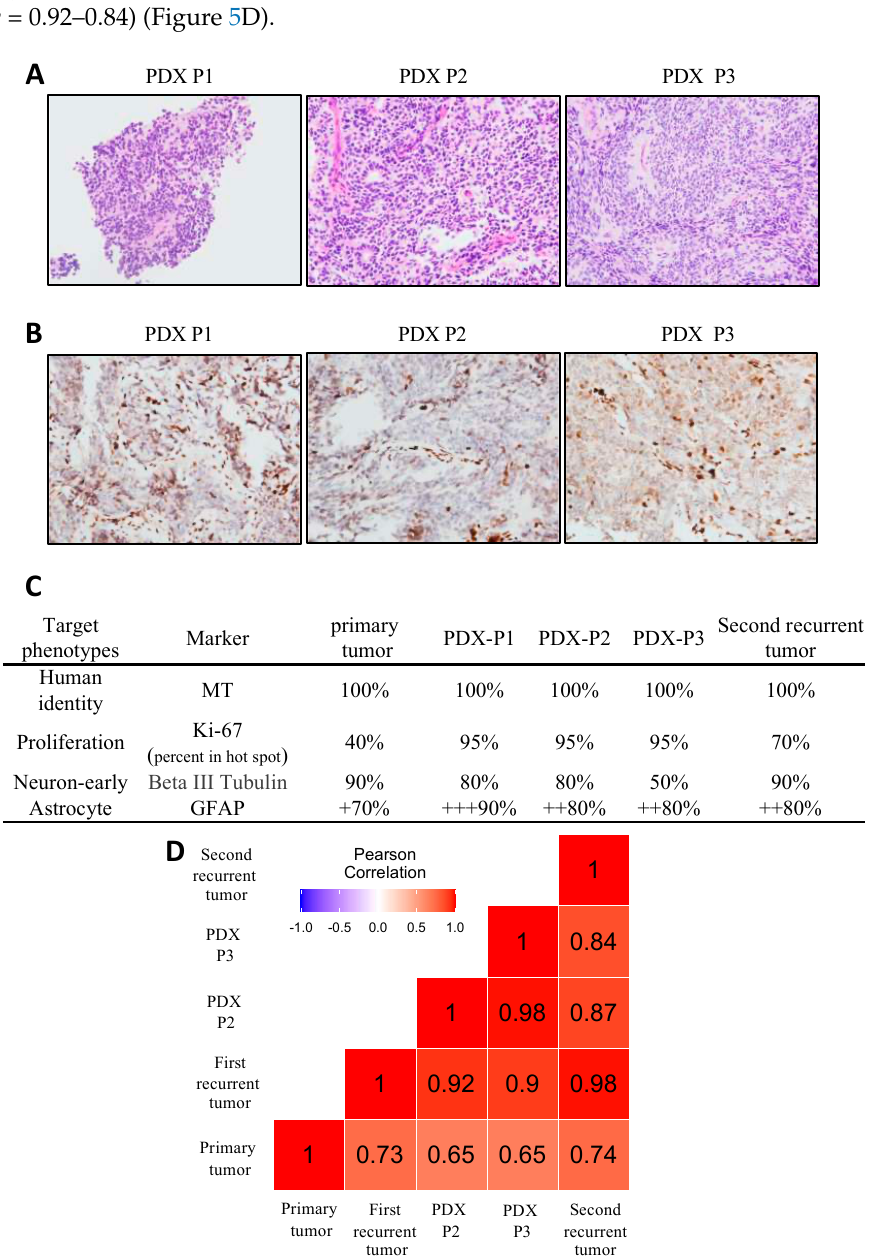
Figure 5. Patient-derived ependymoma xenograft validation. ( A , B ) IHC analyses confirmed the H&E ( A ) and H3K27me3 ( B ) results in all xenografts. PDX-P1: The first generation. PDX-P2: The second generation. PDX-P3: The third generation (400× magnification). ( C ) Summary of the IHC features of the patient’s tumors and all xenografts. +: weak staining, ++: moderate staining, +++: strong staining. ( D ) The matrix represents the relationships between the primary tumor, recurrent tumors, and xenografts. A higher number indicates a closer relationship.